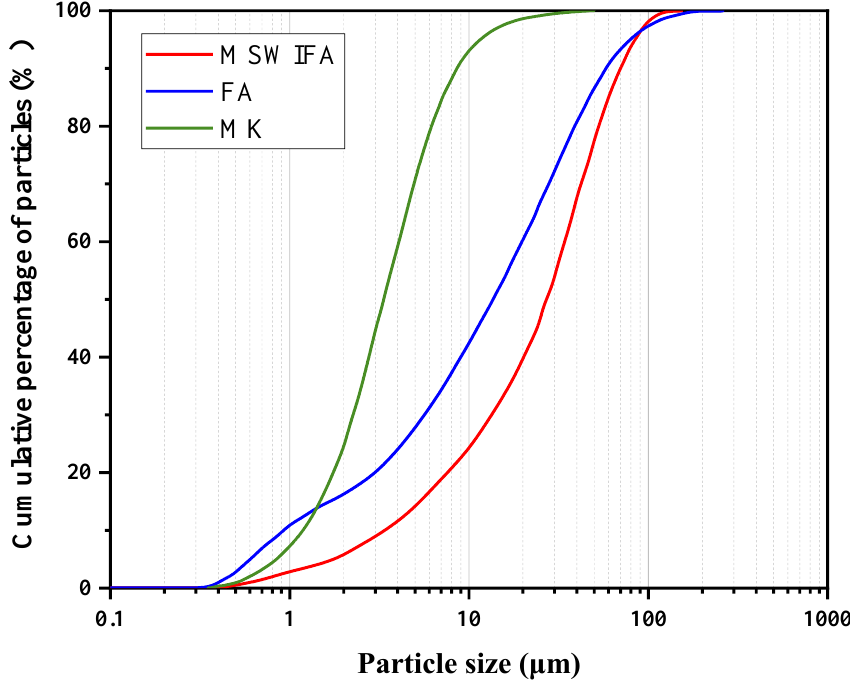
Figure 2. The particle size distribution of MK, FA, and MSWIFA. Table 1. The chemical compositions of MK, FA, and MSWIFA (wt. %).